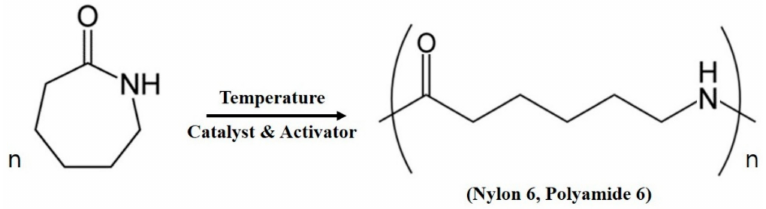
Figure 1. Anionic polymerization of ε